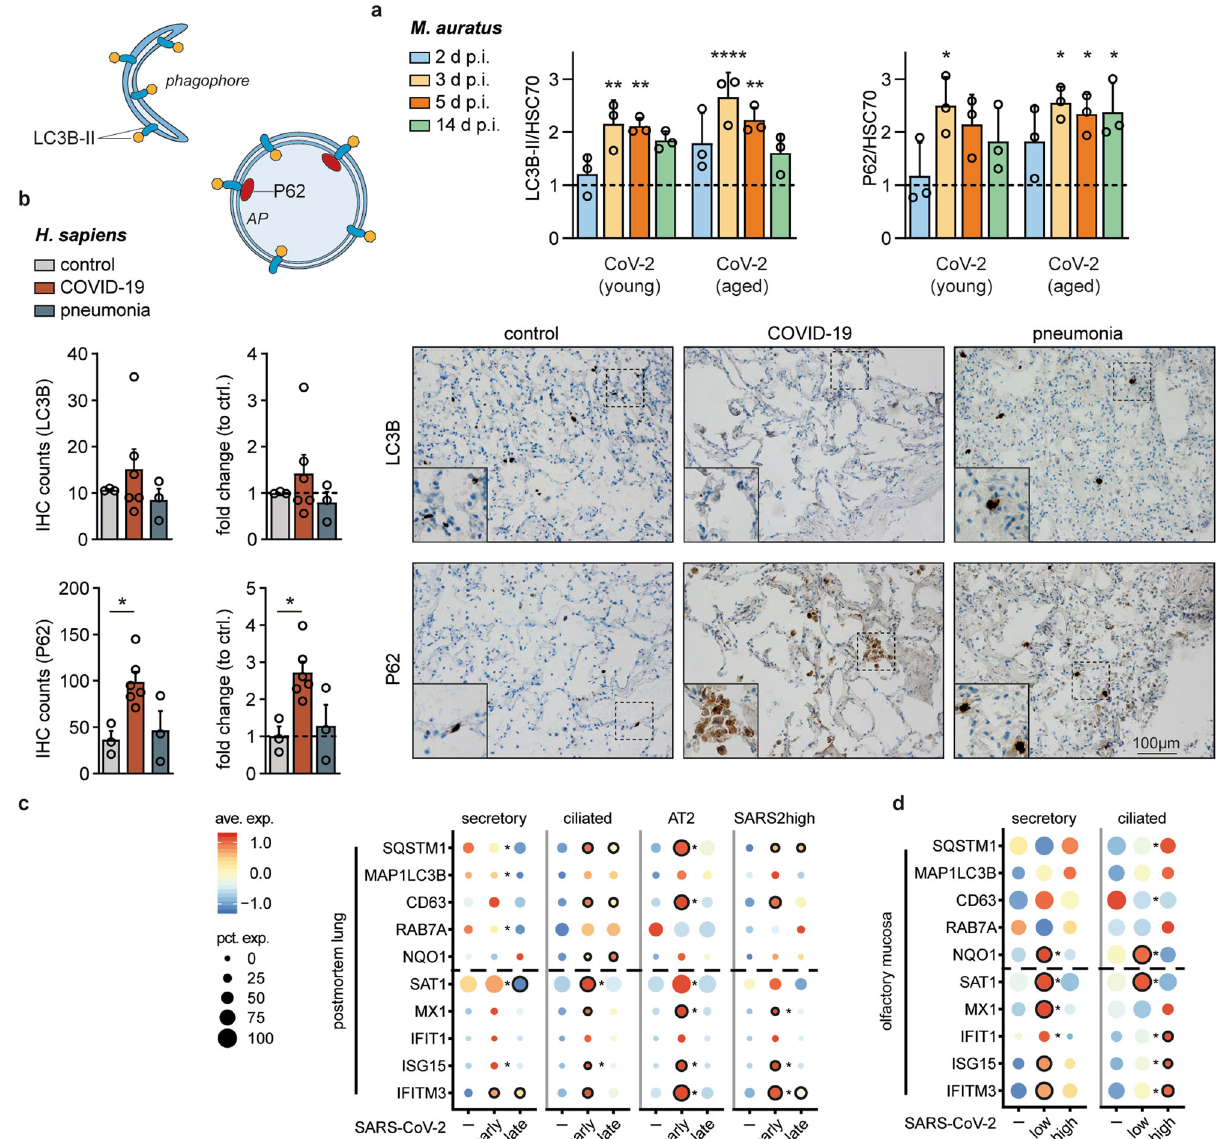
Fig. 3 SARS-CoV-2 replication-dependent and cell-speci fi c regulation of autophagy in vivo. a Enhanced relative LC3B-II/HSC70 and P62 protein levels in lung samples of SARS-CoV-2-infected compared to mock-infected hamsters (dotted line). Syrian hamsters ( Mesocricetus auratus, n = 3 per group, one experiment) were infected or mock-infected (heat-inactivated virus) with 1x10e5 plaque-forming units SARS-CoV-2 by intranasal instillation. Lung samples were taken at days 2, 3, 5, 14 post infection, and protein lysates were analyzed by Western blotting. P-values were determined by two-way ANOVA, Tukey ´s post hoc test, mean with SD. b Immunohistochemistry (IHC). Increased amount of P62 and LC3B-positive cells in formalin- fi xed and antibody-stained lung samples from deceased COVID-19 ( n = 6), pneumonia ( n = 3), and control patients ( n = 3). For each sample, 4 randomly chosen microscopic fi elds (40x) were independently rated by two persons. P-values were determined by one-way ANOVA, Dunnett´s, mean with SEM. Scale bar = 100 µ M. c Dot plots depicting scaled average expression of autophagy and immune genes for selected cell types from postmortem lung patient samples separated according to disease duration representing patients deceased within 14 days (early, n = 3) and after 14 days (late, n = 4). d Expression pro fi le of distinct cell types from the olfactory mucosa of COVID-19 patients ( n = 8) separated according to viral loads and compared to healthy controls ( n = 5). Cut-off for the categories “ low ” ( n = 5) and “ high ” ( n = 3) was 10e5 GE per ml swab-derived liquid. Scaled expression levels are color-coded and the percentage of cells expressing the gene is size-coded. Differential expression analyses were calculated with MAST, and p-values were adjusted with the Benjamini- Hochberg method. For comparisons to the uninfected control, signi fi cance is indicated by a black circle. For comparisons between conditions (early vs. late or low viral load vs. high viral load) signi fi cance is depicted by an asterisk. p ≤ 0.05 (*), p ≤ 0.01 (**), p ≤ 0.001 (***), p ≤ 0.0001 (****), p > 0.05 (not signi fi cant, ns). Ave. Exp. = average expression, Pct. Exp. = percent of cells expressing the cells, Supplementary Table 7), we suspected that SARS-CoV-2 high (>10 5 GE/ml, n = 3) virus RNA concentrations (Supplemen- replication levels might in fl uence transcriptional regulation. To tary Table 8). Seven out of 8 patients were severely ill and all further explore this, we re-analyzed single-cell sequencing (scSeq) samples were taken within the main phase of virus replication ( fi rst data sets from mucosal brushes of hospitalized COVID-19 11 days post onset of symptoms) 40 . In patients with low SARS- CoV-2 RNA levels, we found that prototypic autophagy-related patients 38 experiencing low to moderate (<10 5 GE/ml, n = 5) or